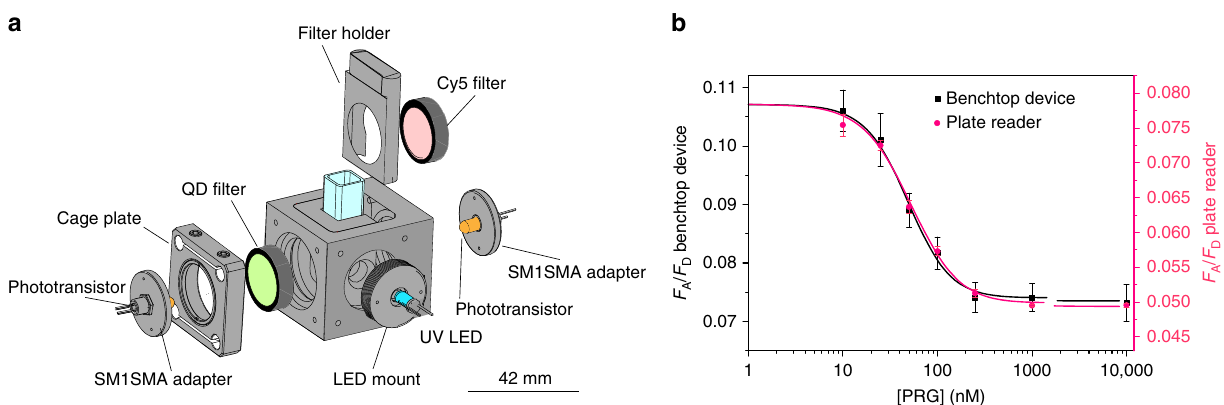
Fig. 4 Low-cost portable reader. Proof-of-concept device demonstrating point-of-care use built using inexpensive off-the-shelf electronics. a Exploded view of device. The sensor is excited by a UV LED. Filters are used to isolate QD and Cy5 fl uorescence emissions, which are then detected by two phototransistors. Scale bar = 42 mm. Full schematic in Supplementary Material. b Sensor accuracy using the low-cost prototype device matches accuracy using a high-end plate-reader. Error bars are standard errors over three experiments. Data for reported means in panel B are available in the Source Data fi le. CAD fi les for panel a cage plate, LED mount, fi ber adapter plates, and cuvette holder were purchased from